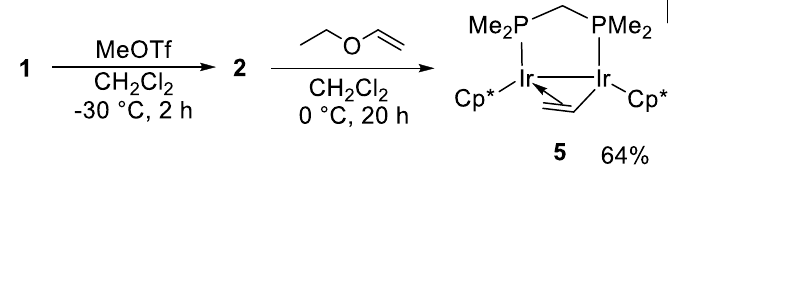
Figure 4. ORTEP drawing of the cationic part of 5 . Hydrogen atoms are omitted for clarity. To obtain information concerning the mechanism of the formation of 5 , the reaction of 2 with ethyl vinyl ether was monitored by the 1 H and 31 P{ 1 H} NMR analyses from − 40 °C to room temperature. At the early stage of the reaction (45 min at − 40 °C, 75% conversion of 2 ), the formation of an intermediate C (Figure 5, ca. 30% yield) was observed, which was afforded by the C–H activation of terminal vinyl moiety in ethyl vinyl ether. In addition to C , the formation of other two species, those might be intermediates in the transformation of C to 5 , was observed during the NMR monitoring. However, we could not determine their structures so far. The observed 1 H and 31 P{ 1